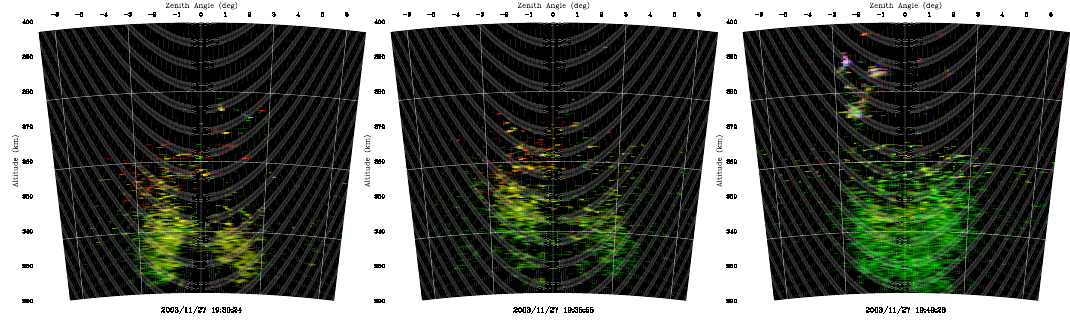
Fig. 4. Aperture synthesis images of the bottom-type layer observed on 27 November 2003 at three local times. Pixel brightness represents the signal-to-noise ratio on a scale from